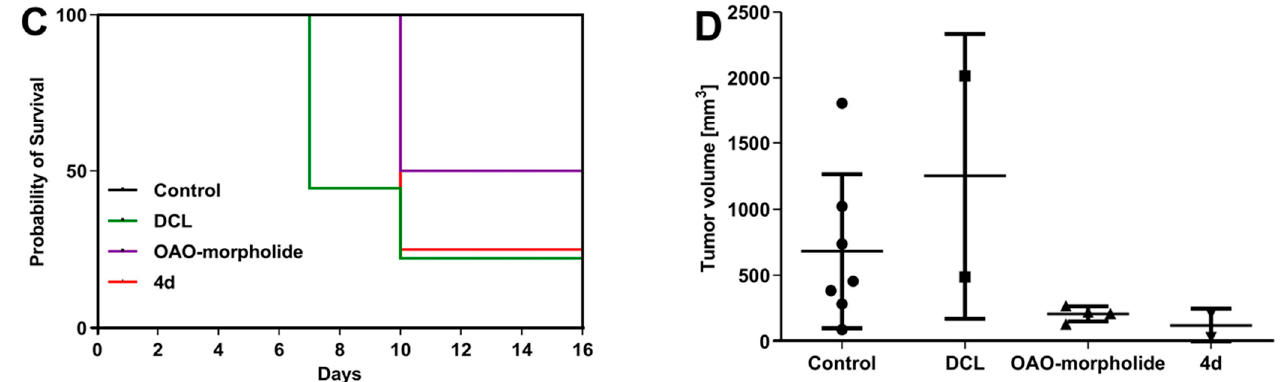
Figure 11. Anti-cancer efficacy of the DCL, and OAO morpholide derivative and their conjugation in HepG2 tumor xenografts. ( A ) The body weight of animals during the experiment. ( B ) The growth curves of the HepG2 tumor xenografts. ( C ) Kaplan-Meier curves for animals bearing the HepG2 xenografts. ( D ) Tumor volumes measured ex vivo following the sacrifice of the mice. The volumes of the tumors on day 6, when tumors were measurable in all animals, were set as 1.